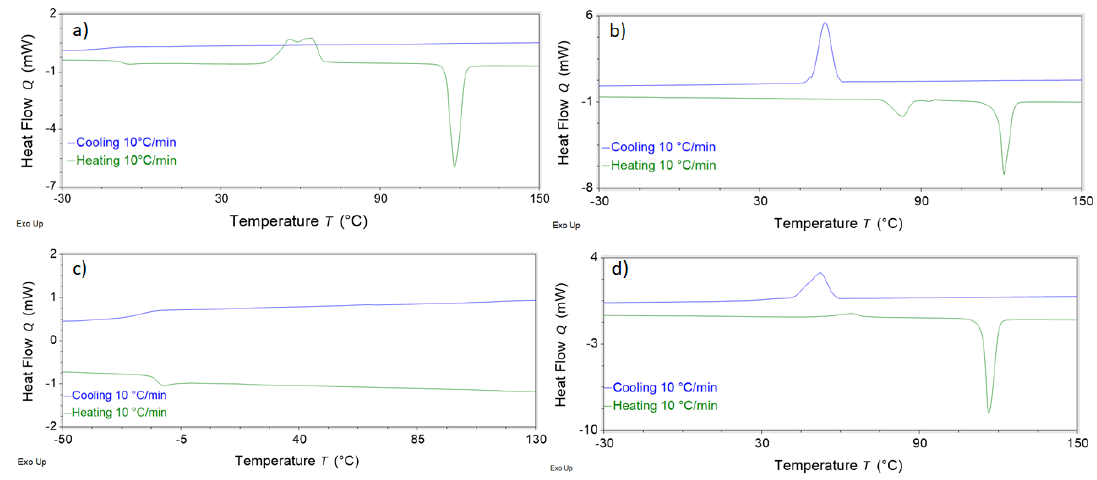
Figure 3. Differential scanning calorimetry (DSC) of compounds 5 ( a ), 6 ( b ), 7 ( c ), and 8 ( d ).